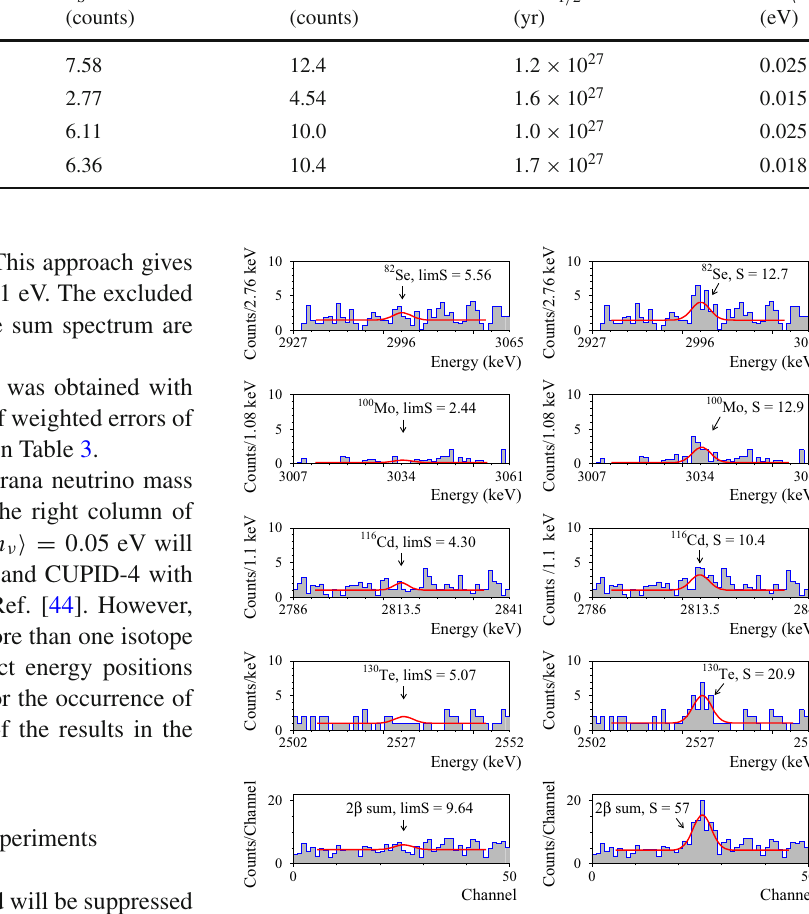
4 and 5. The effect can be detected in both CUPID configu-